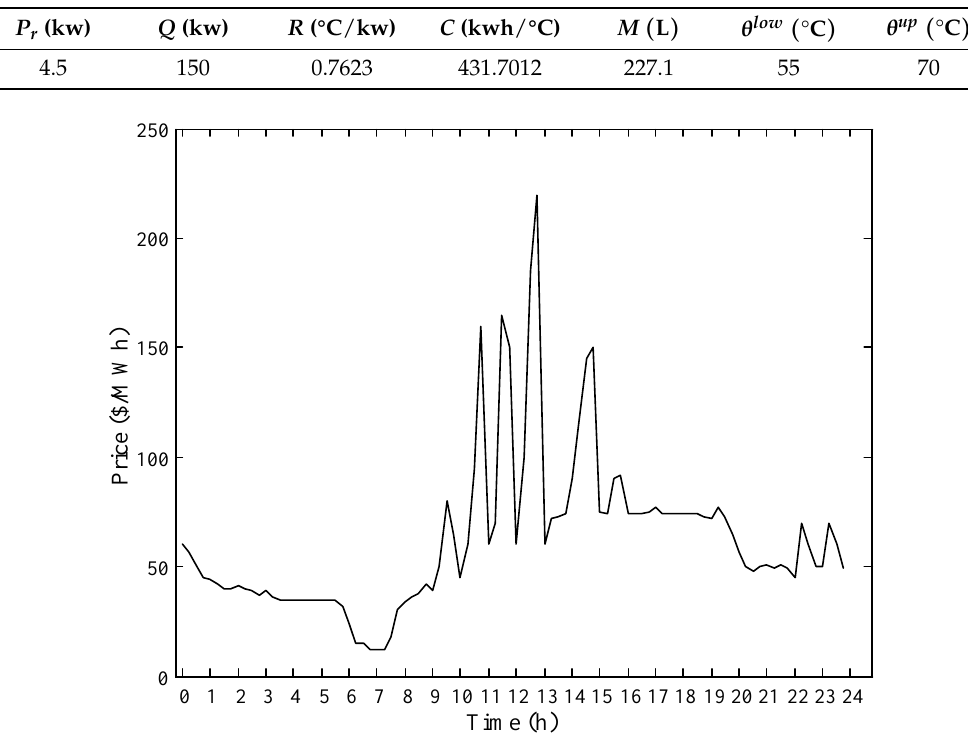
Table 1. Parameters of the domestic electric water heaters (DEWH).